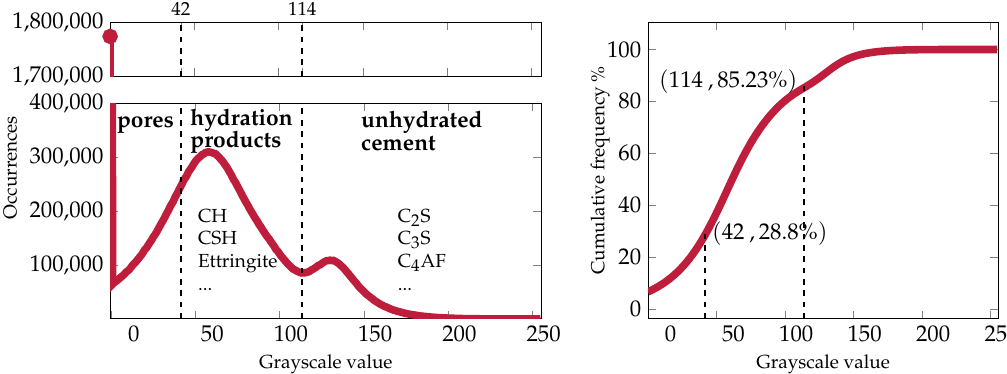
Figure 7. The histogram of the CT sample is segmented into three different phases: pores, hydration phases and unhydrated cement using Powers [45] model (Equation (31)) ( left ). The cumulative frequency of the distribution is shown on the